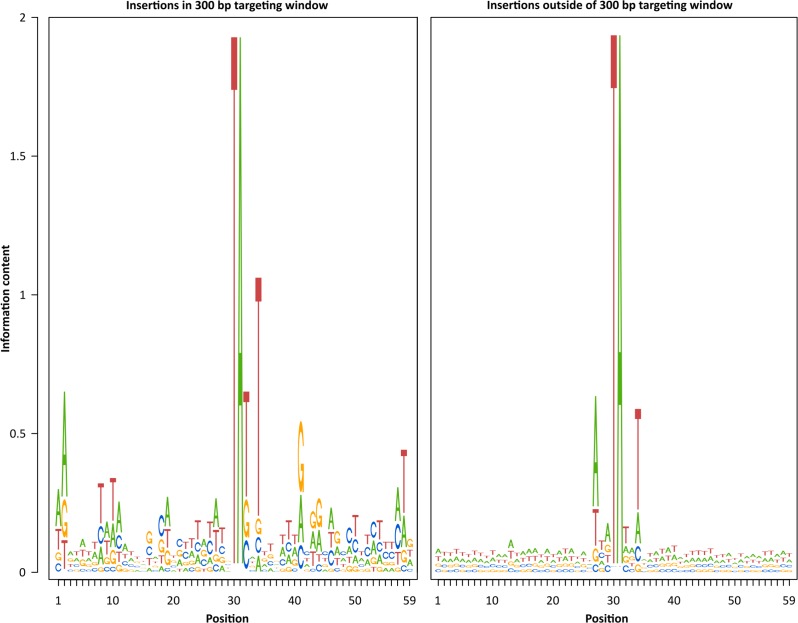
Sequence logos generated from sequences around insertion sites catalyzed by dCas9-SB100X with sgAluY-1 within the 300 bp targeting window (left) and outside of the window (right). The left logo has higher variation at most positions, because of the lower number of insertions.